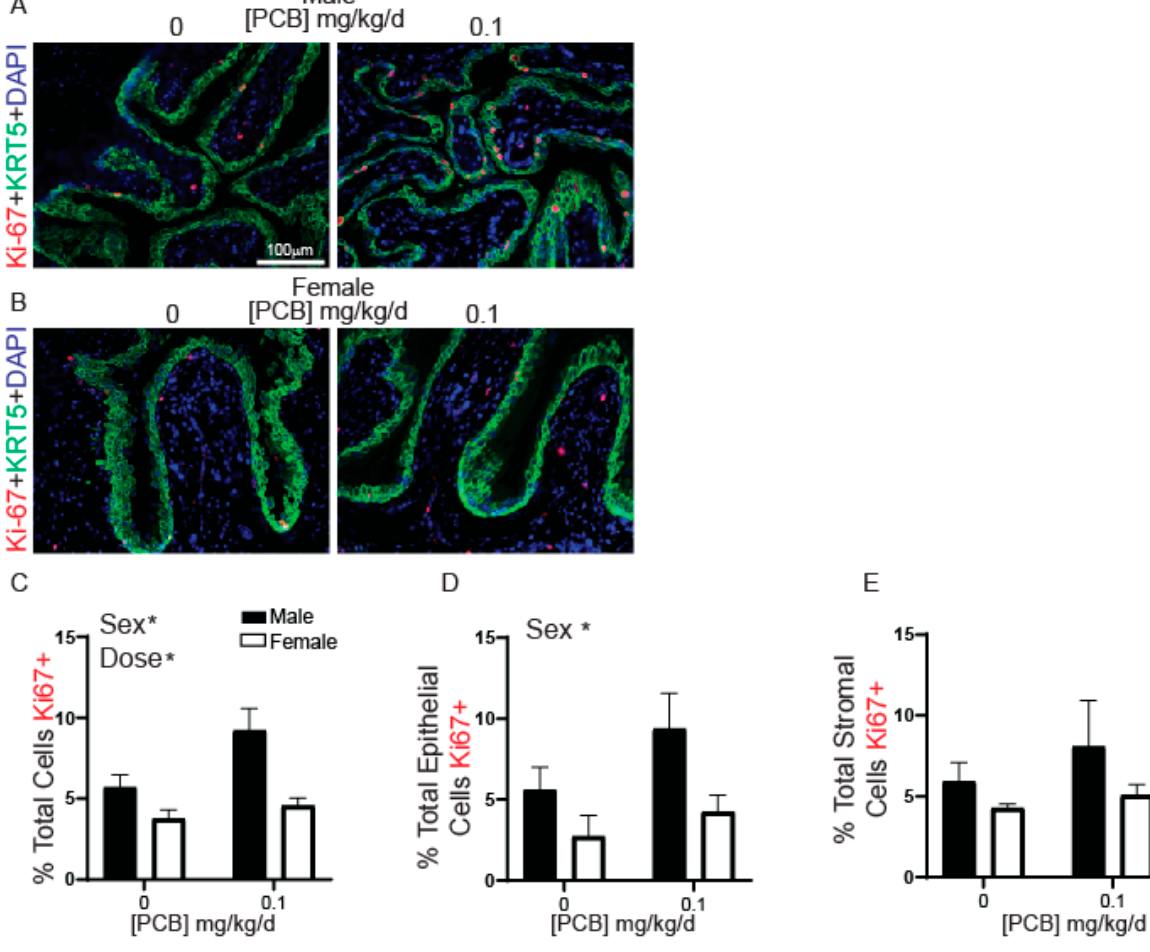
Figure 6. PCBs increase Ki-67-positive cells in male bladder. Mice were exposed to PCBs via maternal diet through gestation and lactation and bladders collected from young male and female offspring at postnatal day (P) 28–31 for immunohistochemistry. Representative images of ( A ) male and ( B ) female mouse bladders at each PCB treatment group incubated with antibodies targeting Ki-67 (red) to label proliferating cells, keratin 5 (KRT5, green) to label basal epithelium and DAPI (blue) to stain nuclei. Quantification of ( C ) the percent of total cells Ki-67 positive, ( D ) the percent of total epithelial cells Ki-67 positive and (E) the percent of total stromal cells Ki-67 positive. Results are the mean ± SEM, n = 4–6 bladders per treatment group, up to 3 images per bladder were averaged for final value. Significant differences at p < 0.05 indicated by asterisk as determined using two-way ANOVA followed by Tukey’s multiple comparisons tests.